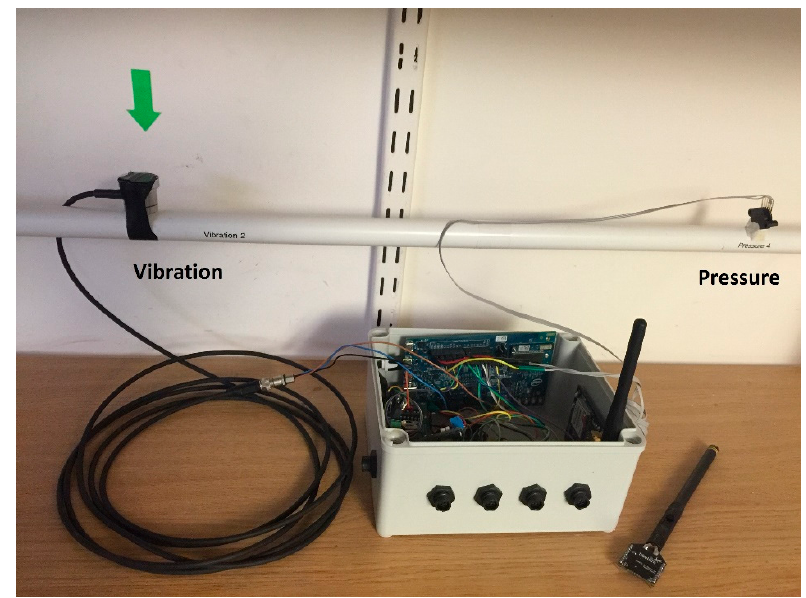
Figure 4. Multi-modal (pressure on the right and vibration on the left) sensing deployment on a pipe. Sensors are wired to a gateway for data collection, analytics and transmission.